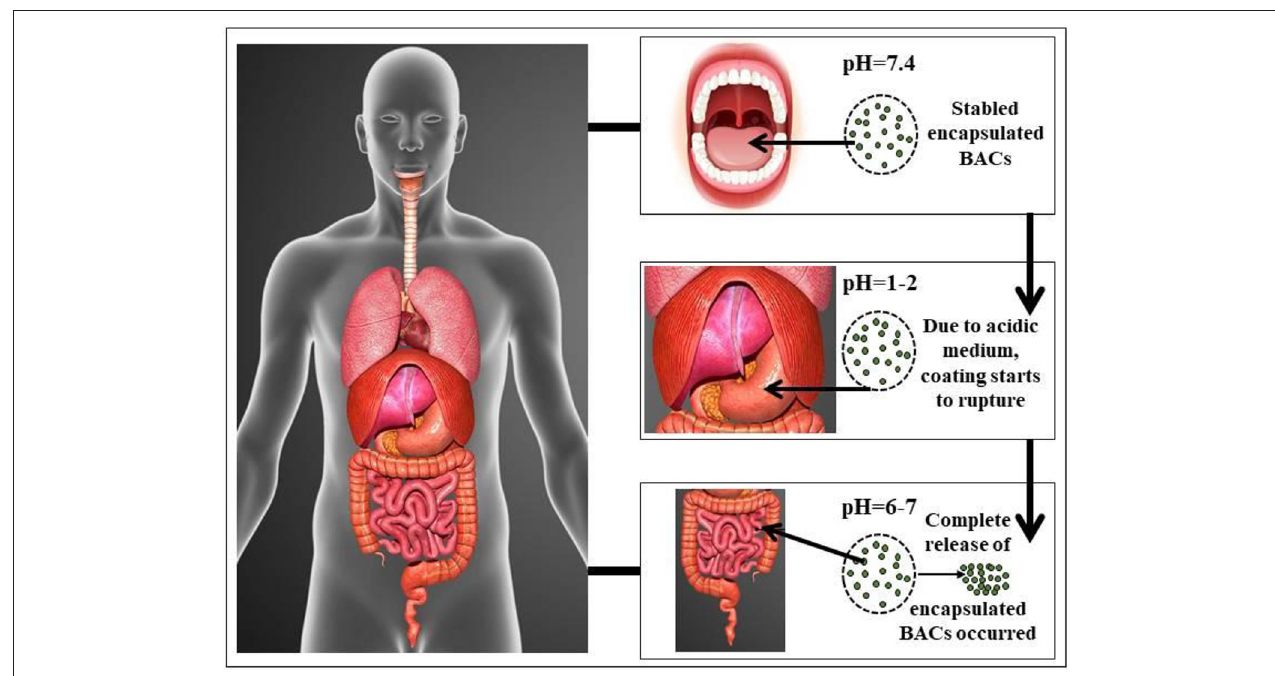
FIGURE 3 | Effect of different pH on the encapsulated bioactive compounds (BACs) in different parts of the human body (11).